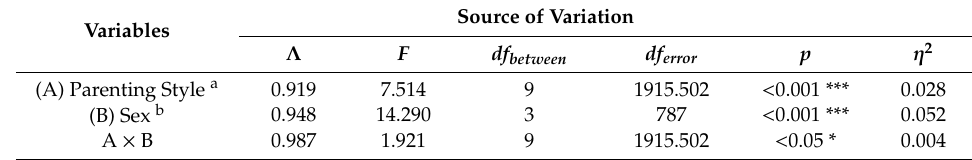
Table 2. Multivariate analysis of variance (MANOVA) results for all the studied variables (4 a × 2 b